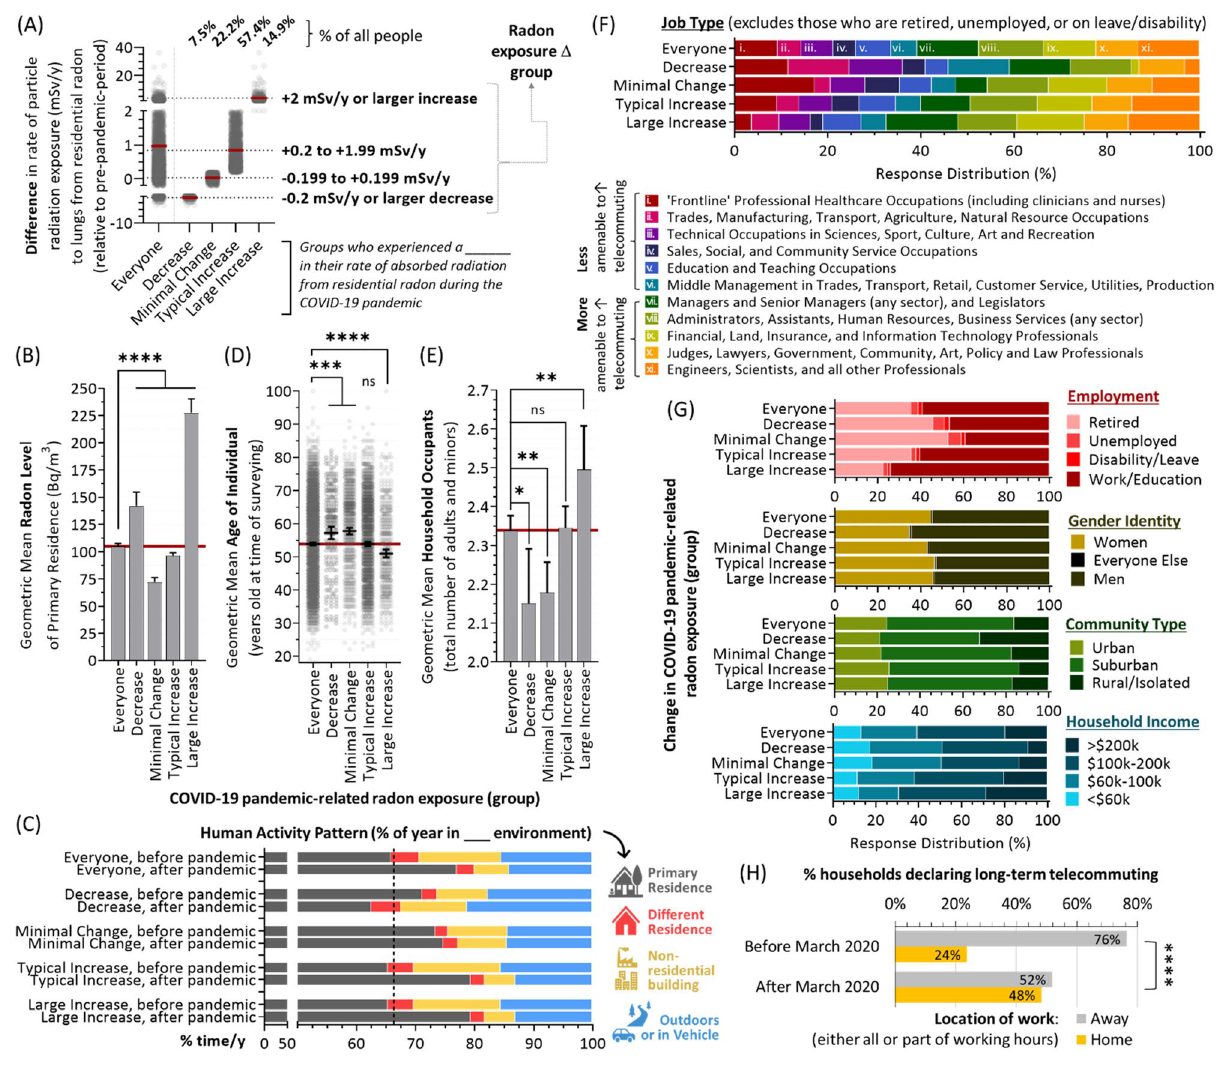
Figure 7. Those experiencing exceptionally large increases in radon exposure following the COVID-19 pandemic are younger, in homes with more occupants, and in telecommuting-amenable jobs. Panel A . The absolute difference in radiation dose rate (mSv/y) from residential radon relative to the pre-pandemic period broken down into the four indicated groups. Panel B . The geometric mean radon level of properties occupied by those in COVID-19 pandemic-related exposure groups defined in ( A ). Panel C . The before and after COVID-19 pandemic onset activity patterns for those in groups defined in ( A ). Panel D . The geometric mean ranges of those in COVID-19 pandemic-related exposure groups defined in ( A ). Panel E . The geometric mean number of household occupants for the COVID-19 pandemic-related exposure groups defined in ( A ). Panel F . Distribution of job types held by those in COVID-19 pandemic-related exposure groups defined in ( A ). Panel G . Distribution of employment status (reds), gender identity (yellows), community type (greens), and household incomes (blues) for those in COVID-19 pandemic-related exposure groups defined in ( A ). Panel H . The percent of households declaring that one or more occupants telecommute (work from home) either all or part of working hours, before and after March of 2020. Pairwise statistical comparisons are Mann–Whitney t-tests. * p < 0.05, ** p < 0.01, *** p < 0.001, **** p < 0.0001; ns = p > 0.05. Figures were prepared using Excel and GraphPad Prism 9.1.1 (225) (www. graph pad.